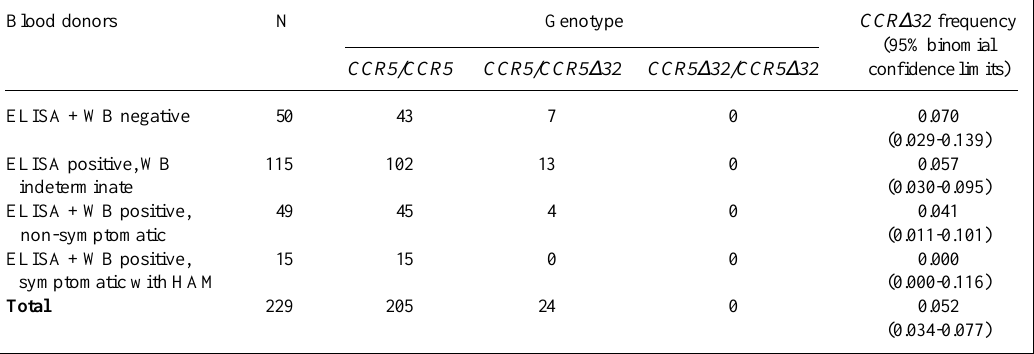
Table II - Determination of the CCR5 ∆ 32 allele frequency in blood donors with different status in reference to HTLV-I infection. Blood donors